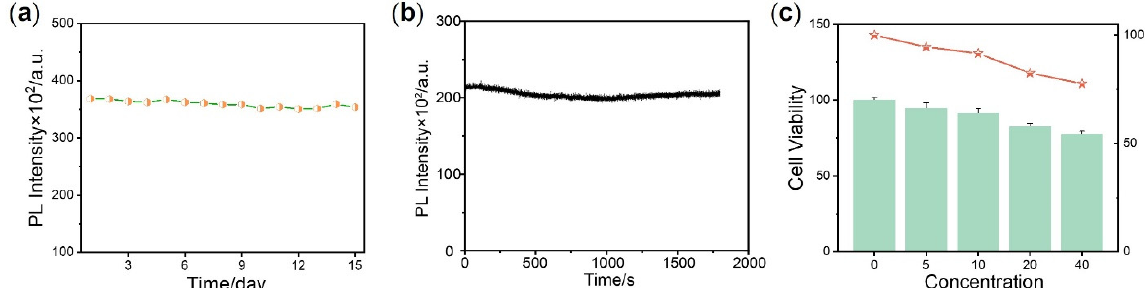
Figure 5. ( a ) The chemical stability test of complex 4 . The sample was preserved at room temperature for 0.5 month, and the PL intensity was measured every other day. ( b ) The photostability test of complex 4 . The sample was exposed under 532 nm